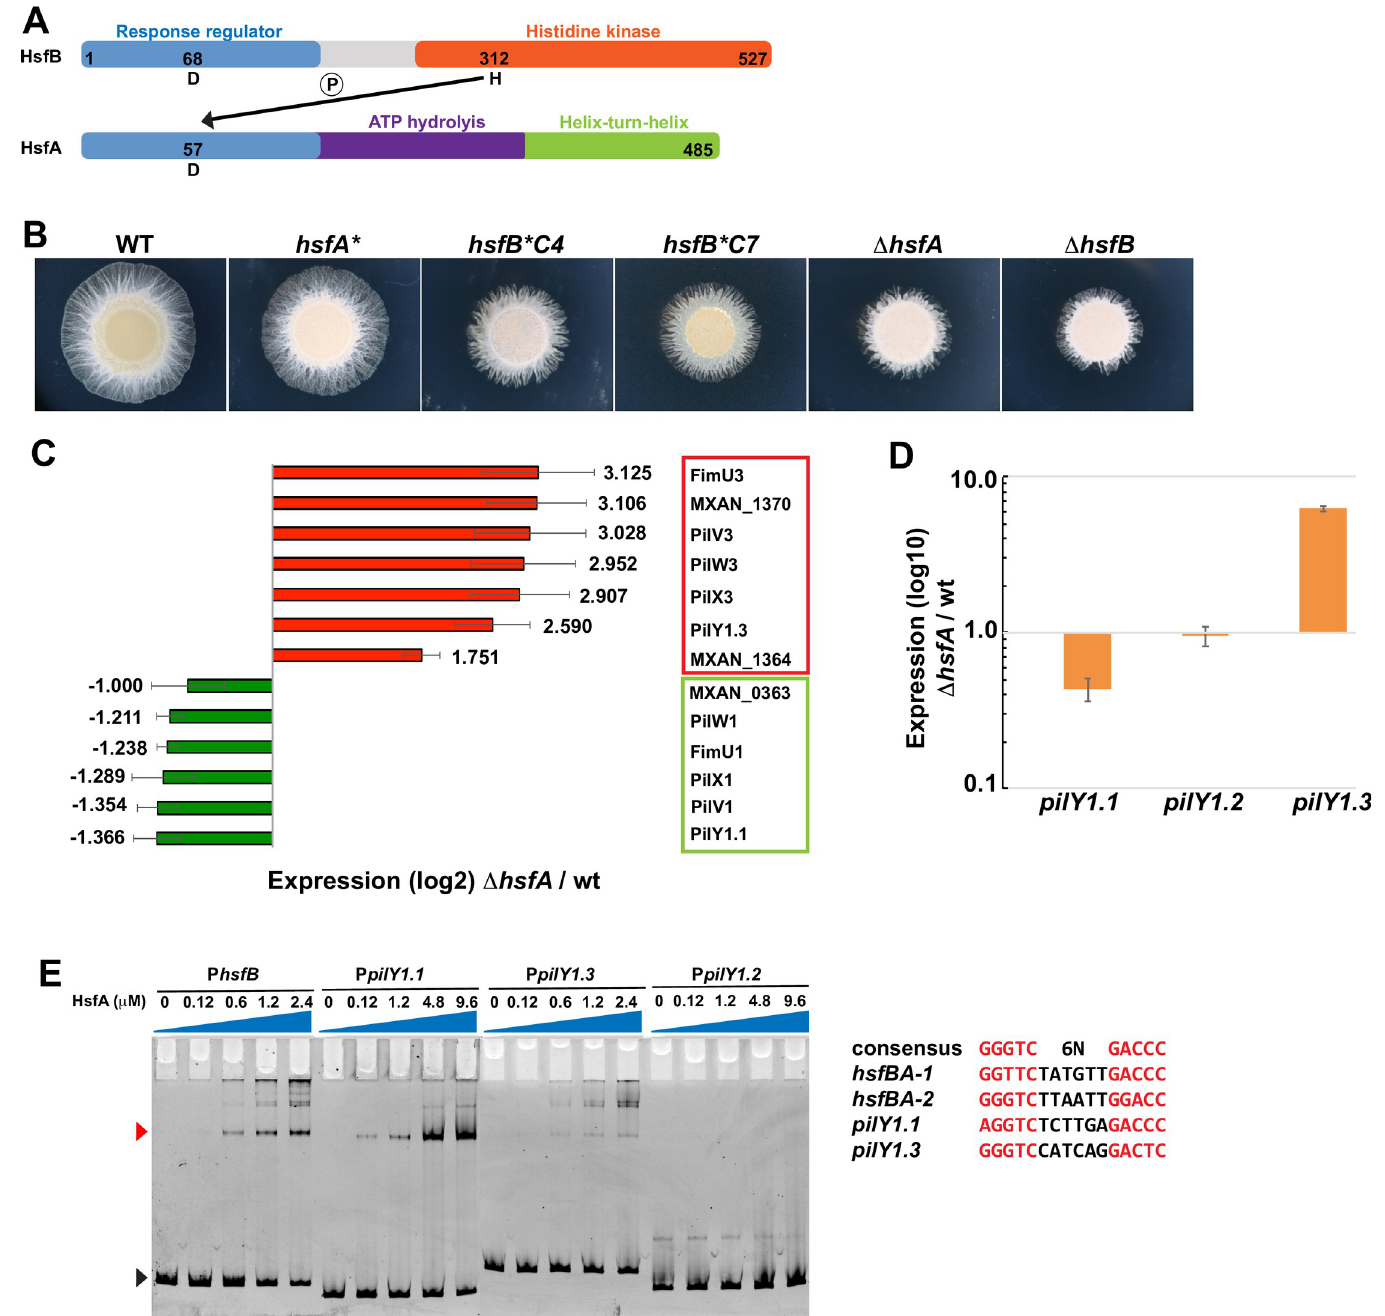
Fig 3. pilY1 . 1 and pilY1 . 3 are divergently regulated by the HsfBA phosphorelay. (A) Schematic representation of HsfB and HsfA. Numbers indicate the aminoacid position; the response regulator domains are in blue; the histidine kinase domain in orange; the ATP hydrolysis domain in purple; the helix-turn-helix domain in green. The arrow indicates the phosphotransfer from the conserved histidine H in HsfB to the aspartate D in HsfA. (B) Motility phenotypes of DZ2 (wild type), EM817 ( hsfA � from sup9 ), EM799 ( hsfB � C4 from sup4 ), EM816 ( hsfB � C7 from sup7 ), EM806 ( Δ hsfA ) and EM807 ( Δ hsfB ) on 0.5% agar at 48H. The star � represents suppressor mutations. (C) Relative expression of the indicated genes in the Δ hsfA mutant measured as log2-fold changes by RNA-Seq. Results are mean values from three biological replicates. The green and red colors indicate up- and down-regulation, respectively, as compared to wild type. (D) Relative expression of the indicated genes in the Δ hsfA mutant vs wild type measured as log10-transformed fold changes by qRT-PCR. Results are mean values from two biological replicates. Error bars indicate standard deviations. Raw data are available in S4 Table. (E) Representative Electrophoretic Mobility Shift Assays (EMSA) on 6.5% polyacrylamide. The indicated concentrations of purified His 6 -HsfA were incubated with the indicated DNA fragments. White and red arrowheads indicate free DNA and His 6 -HsfA-bound DNA, respectively. Putative HsfA binding in P , P , P are aligned against the consensus. Conserved nucleotides are in hsfB pilY1 . 1 pilY1 . 3